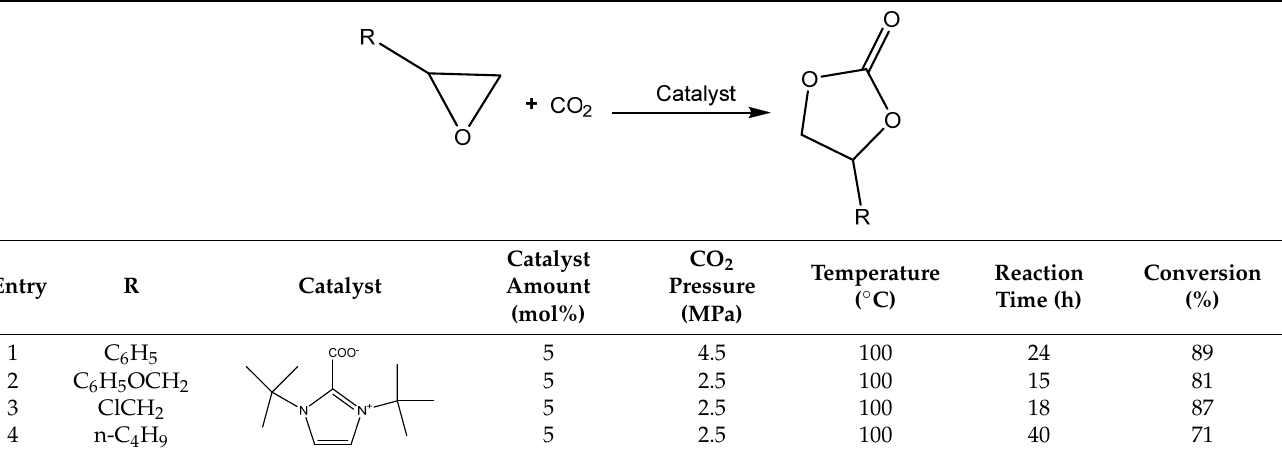
Table 13. Cycloaddition of CO 2 to epoxides catalyzed by 1,3-di-tert-butylimidazolium-2-carboxylate [65].